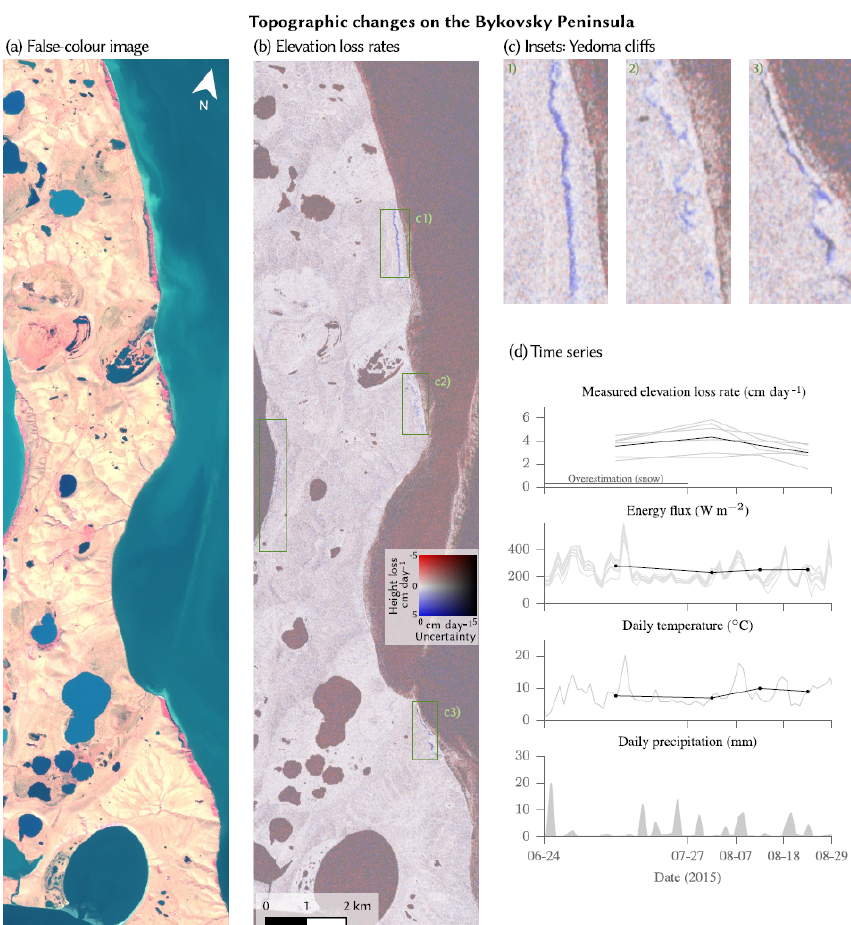
Figure 7. Rapid permafrost degradation occurred at coastal thaw slumps on the Bykovsky Peninsula. (a) Sentinel-2 image. (b) Mean elevation loss from 27 July to 28 August 2015 r s estimated from TanDEM-X is large at yedoma cliff slumps (rectangles). (c) Magnified images showing three coastal stretches from (b) . (d) Time series of observed elevation loss rates r at cliffs (aggregated along headwall) and atmospheric conditions similar to Fig. 4, except that the topmost panel shows the dynamics of all cliffs (grey) and their average